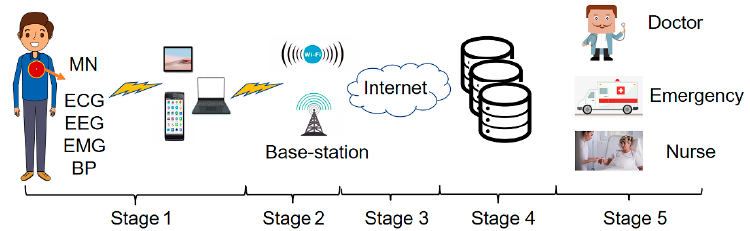
Figure 1. Real-time monitoring and remote transmission of human physiological signals.